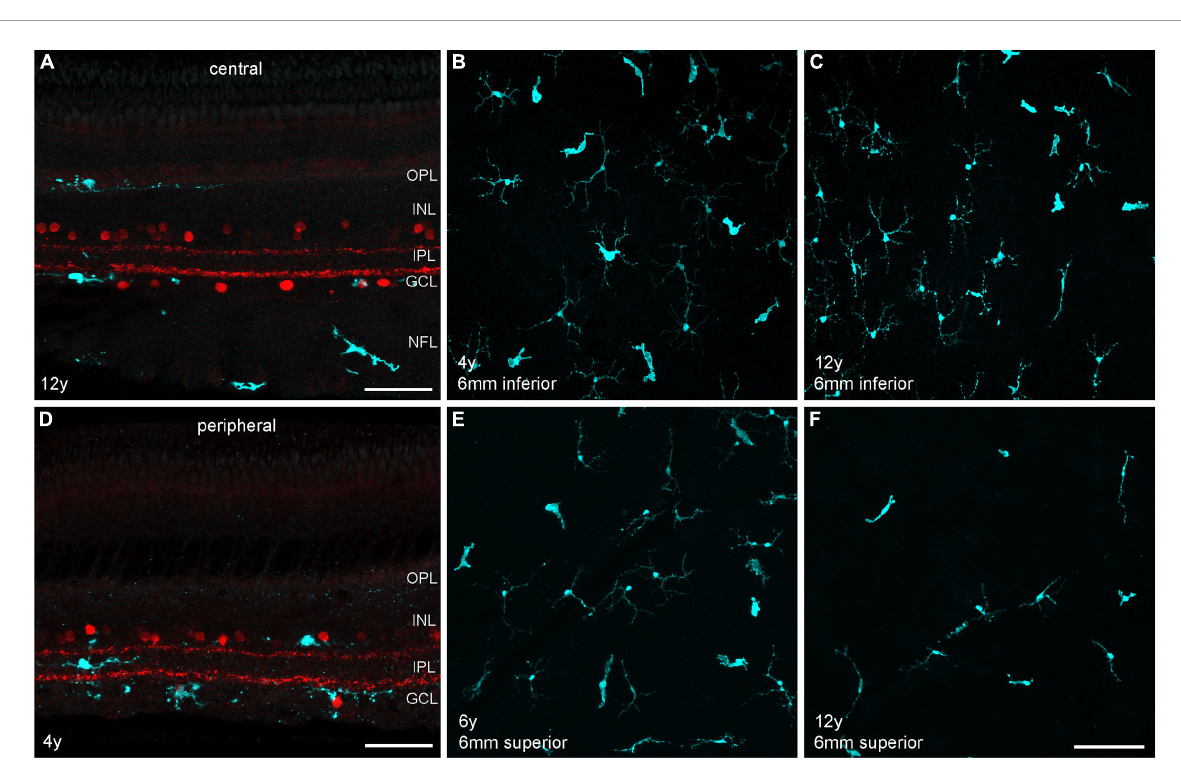
dendrites at all. We observed peripheral sprouts in only three individuals: We found six sprouts in the peripheral retina of a 12-year-old male and two sprouts in the peripheral retina of a 15-year-old female. One sprout was in contact with an ectopic presynaptic ribbon ( Figure 8B ). For comparison,